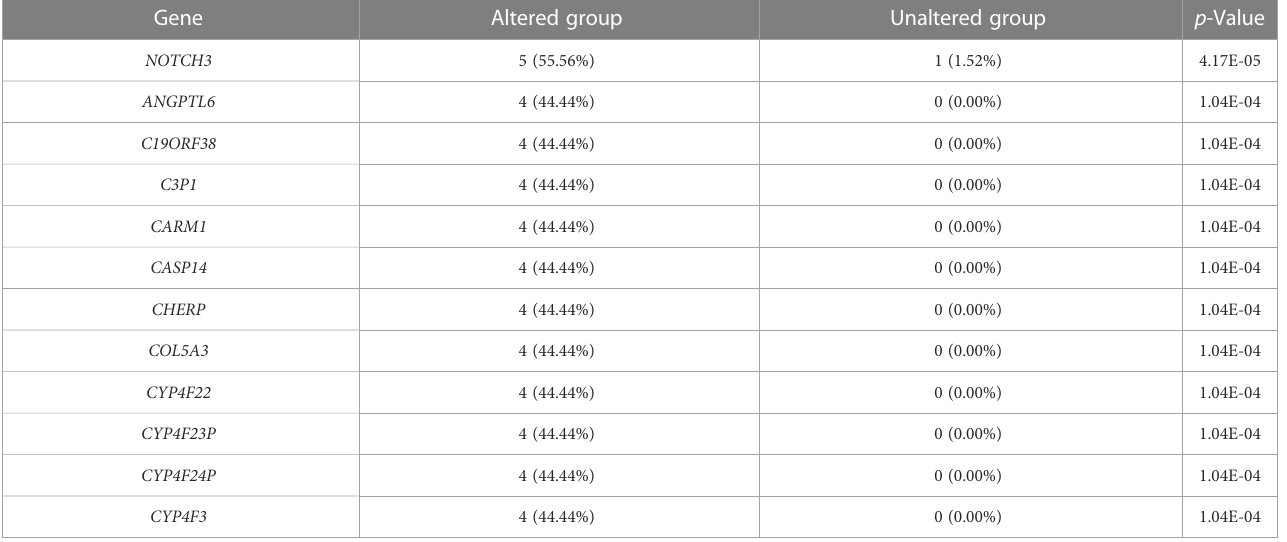
TABLE 3 The top 50 of BRD4 neighbor gene alterations in ACC